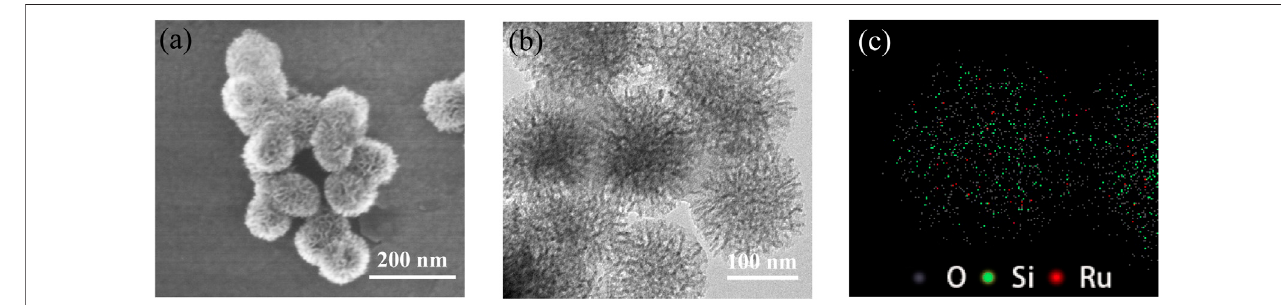
FIGURE 4 | SEM image (A) , TEM image (B) , and EDS mapping (C) of catalyst 2.